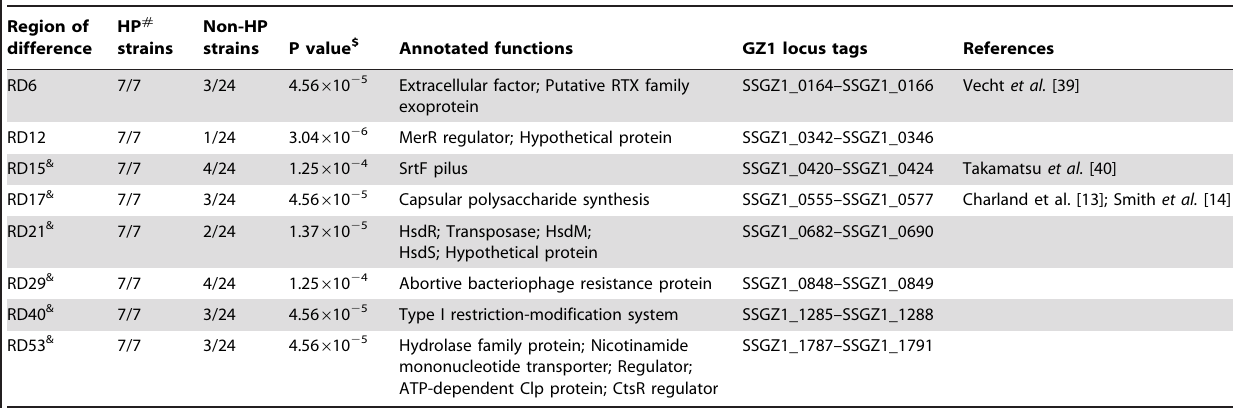
Table 2. Regions of difference associated with high